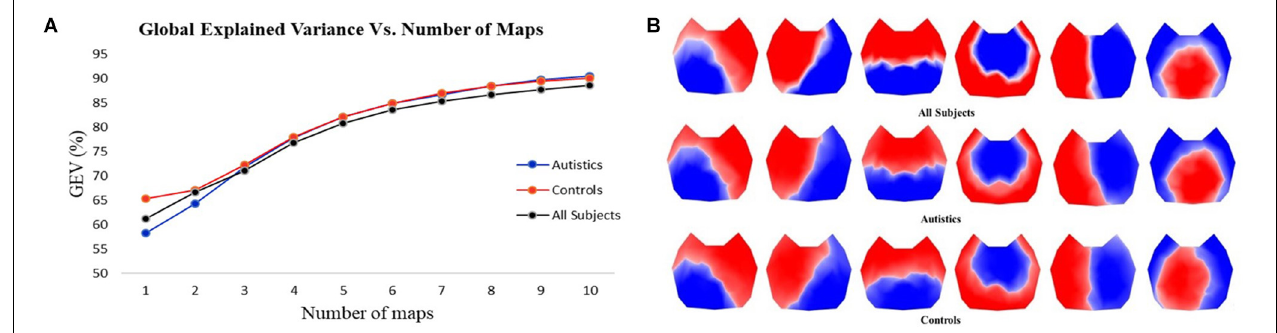
FIGURE 2 | (A) GEV vs. number of template maps using three different approaches in the cluster analysis: considering only autistics (blue curve), only controls (red curve), and all subjects (black curve). (B) Template topographies of the six classes of microstates using three approaches: all subjects (top row), autistics (middle row), and controls (bottom